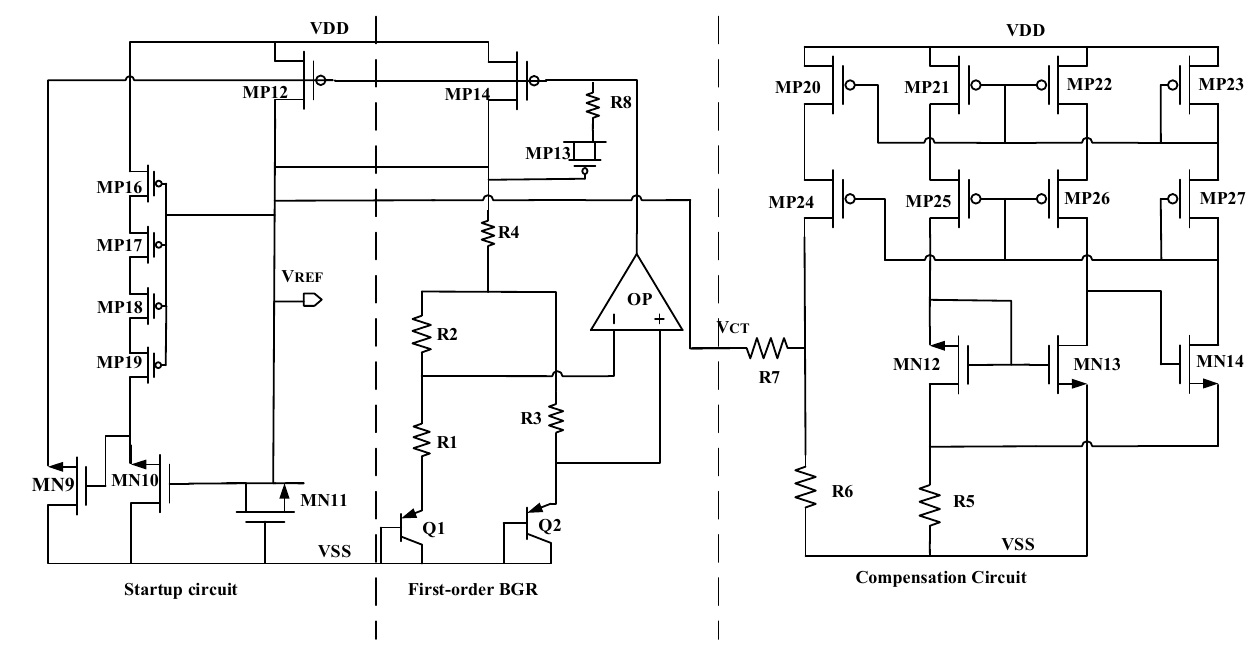
Figure 3. Schematic of the proposed BGR.